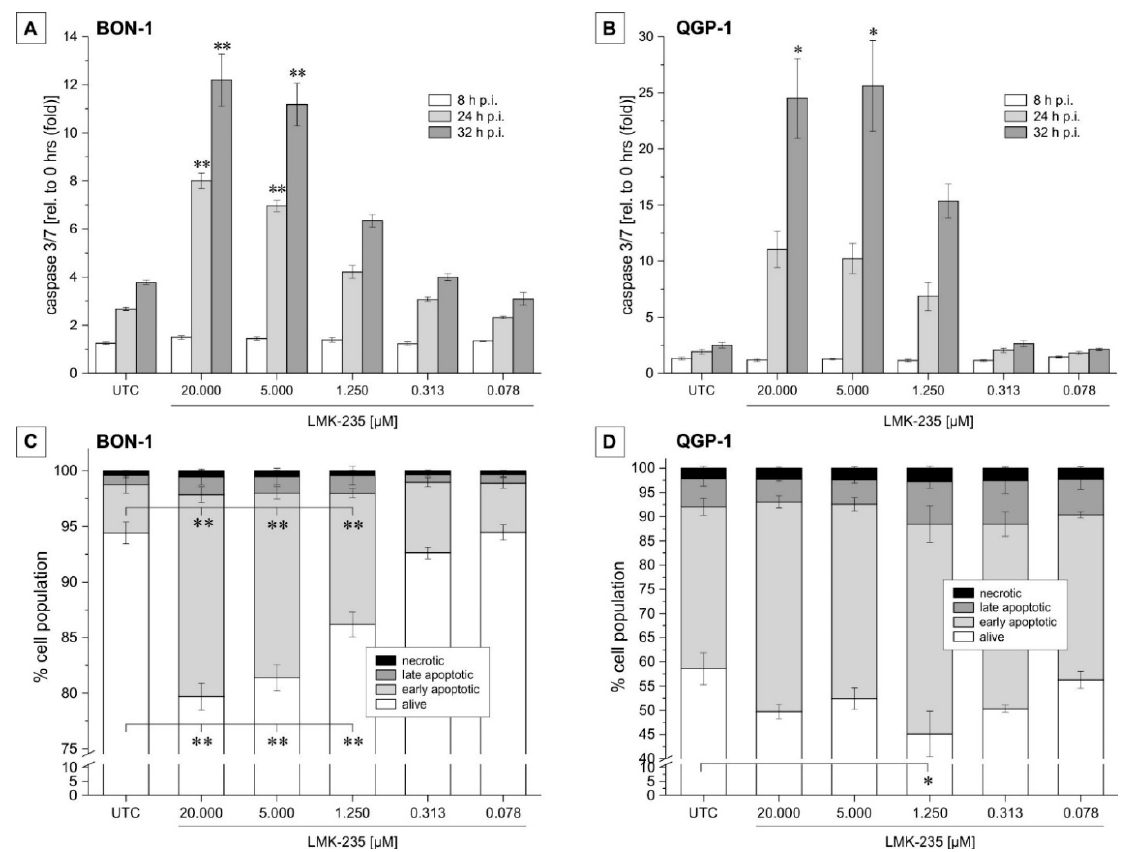
Figure 2. LMK-235 effects on apoptosis induction in pNET cells. ( A , B ) BON-1 ( A ) and QGP-1 ( B ) were incubated for 8, 24, and 32 h with different LMK-235 concentrations (0.078–20 µM). Relative changes in caspase activity were measured as a parameter for treatment-induced apoptosis. Bars represent mean ± SEM for n = 4 experiments. ( C , D ) Flow cytometry results of Annexin V/7-AAD staining are shown for BON-1 ( C ) and QGP-1 ( D ). Bars represent the cumulative percentages ( n = 3) for alive, early, or late apoptotic and necrotic cells when treated for 24 h with LMK-235 (0.078–20 µM). Asterisks indicate p -values of <0.05 (one) or <0.01 (two) versus corresponding untreated control. Abbreviations: p.i. = post incubation, UTC = untreated control.